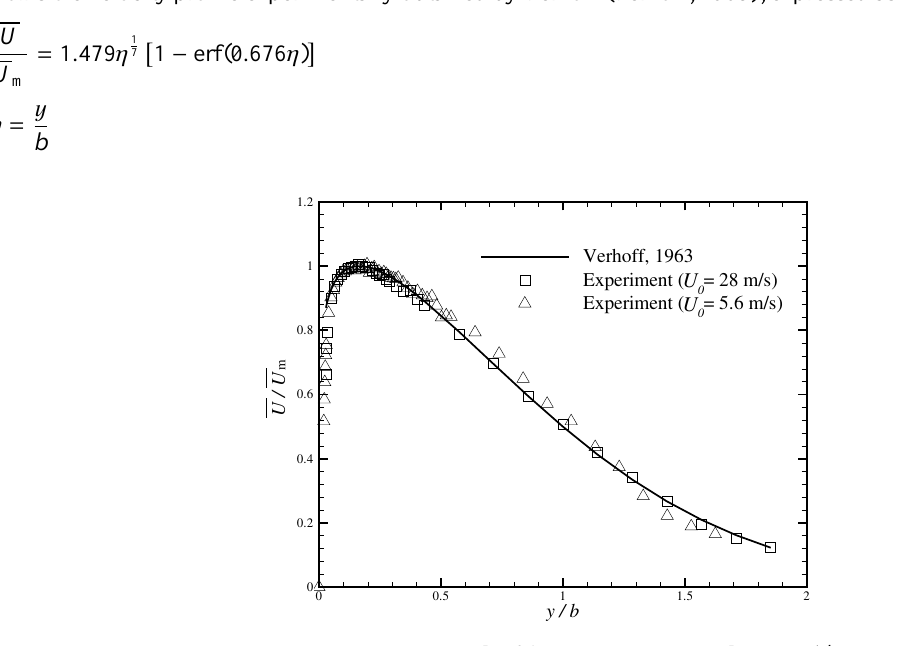
Fig. 12 Cross-streamwise profile of the mean streamwise velocity at x / d = 30.